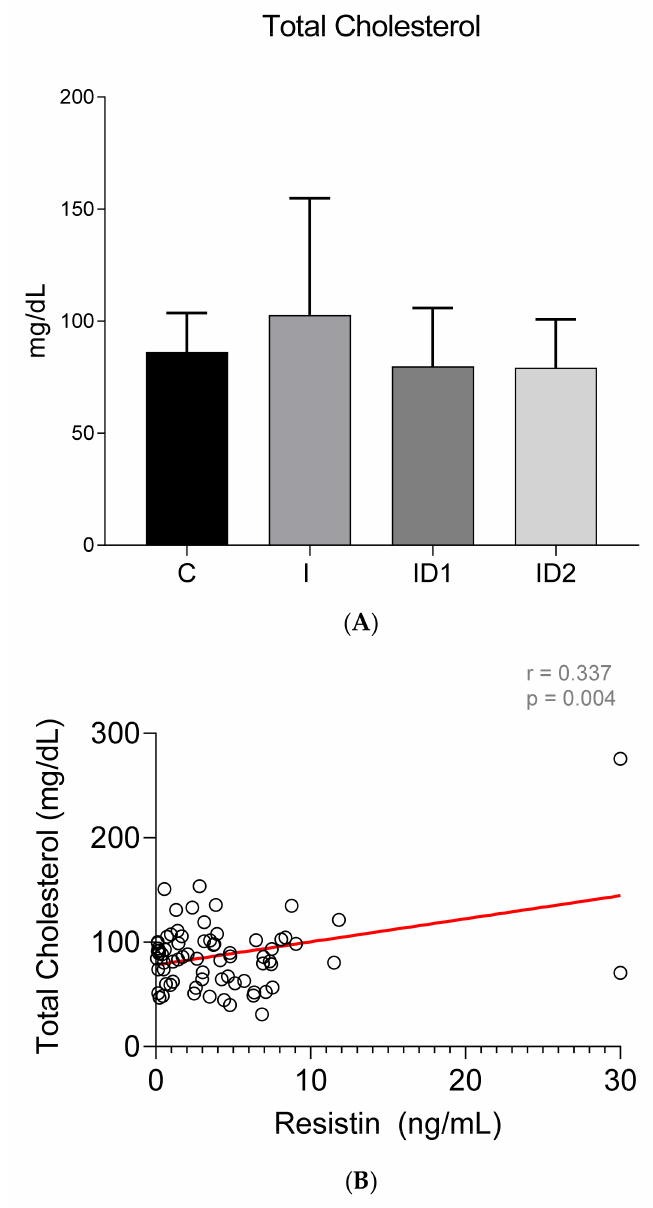
Figure 7. ( A ) Plasma total cholesterol concentration (mg/dL) in the different groups. Control group (C) n = 14, inflammatory group (I) n = 21, mild insulin resistance group (ID1) n = 18, severe insulin resistance group (ID2) n = 19. Bars represent mean + SD. ( B ) Correlation between plasma total cholesterol concentration (mg/dL) and plasma resistin concentration (ng/mL) in 72 horses. The linear regression line is draw red solid (n = 72, r = 0.337, p =